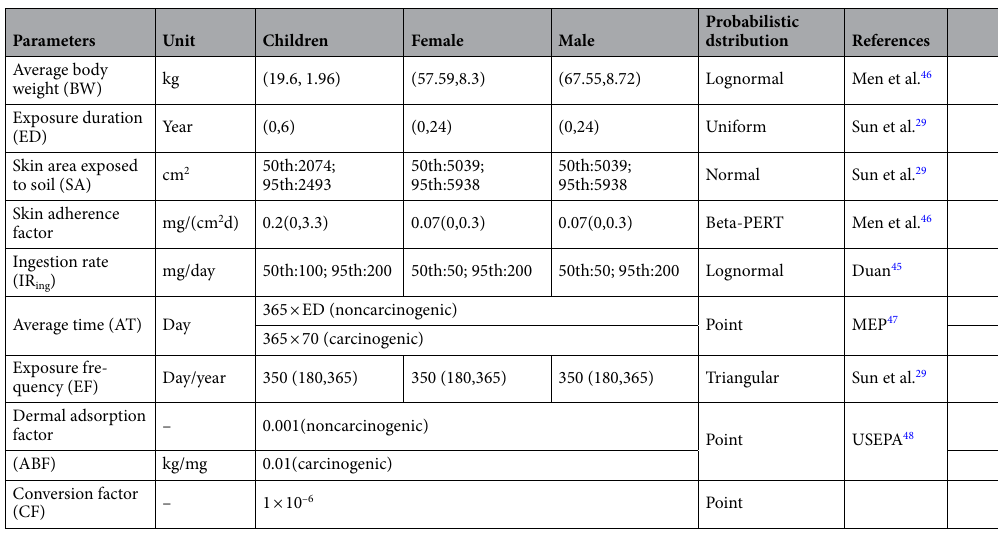
Table 1. Calculation parameters and values used in health-risk assessment to evaluate soil exposure risk with Monte Carlo simulation. (a1, a2) defines the mean and standard deviation of lognormal distribution; (b1, b2) defines the minimum and maximum values of uniform distribution; 50th and 95th are the values at 50% and 95% of normal distribution, respectively; c1 (c2, c3) defines the most likely, minimum, and maximum values of beta PERT distribution, respectively; and d1 (d2, d3) defines the most likely, minimum, and maximum values of triangular distribution, respectively.